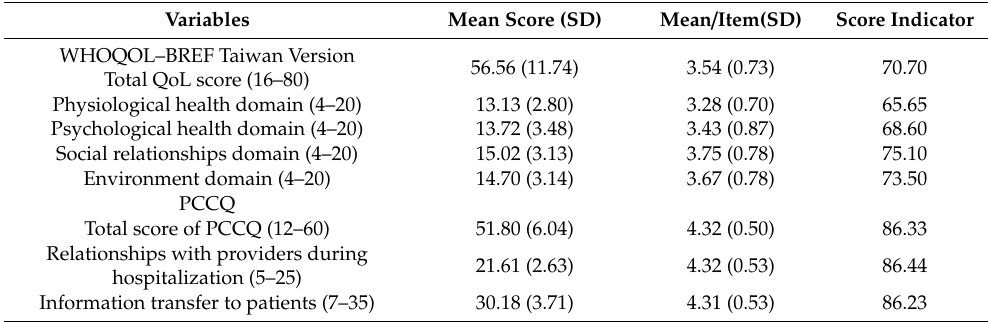
Table 2. World Health Organization Quality of Life QoL Questionnaire (WHOQOL–BREF) Taiwan version, Patient Continuity of Care Questionnaire (PCCQ) scores and risk of disability in patients with coronary heart